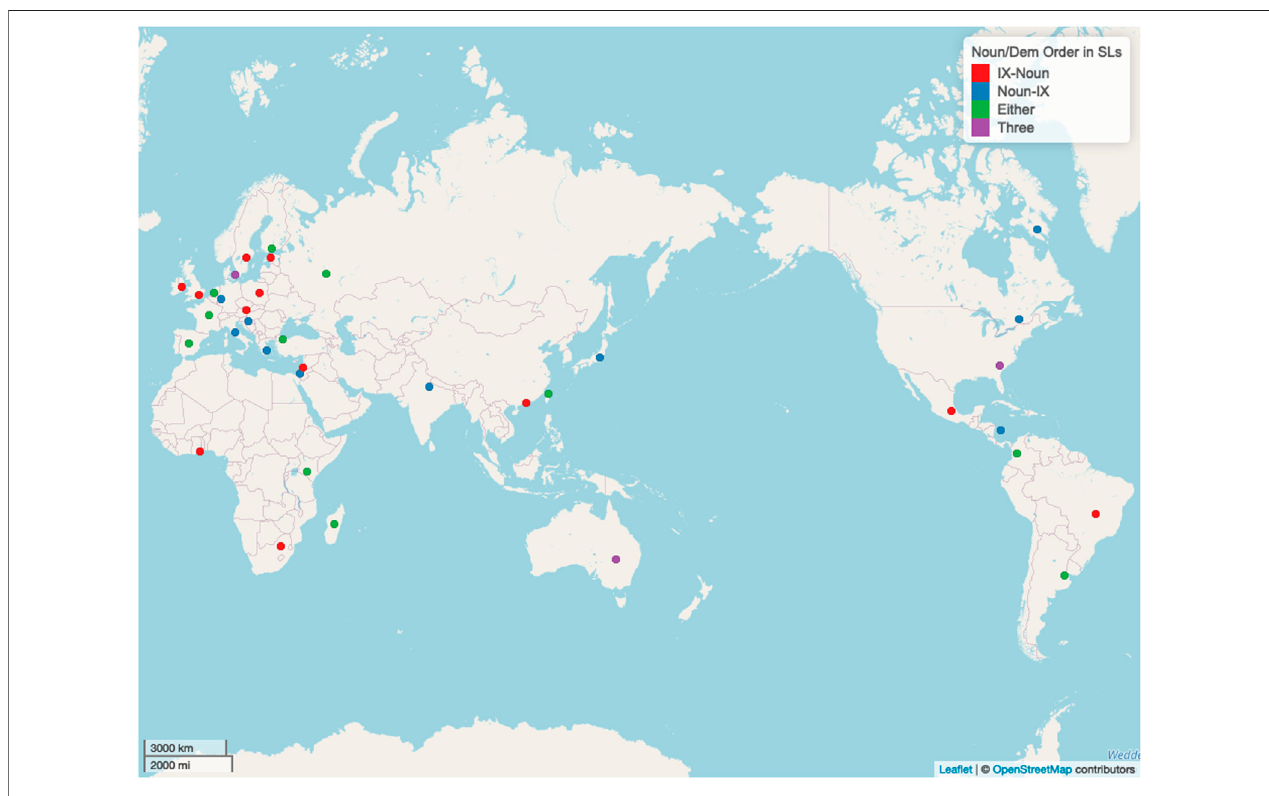
FIGURE 4 | Map of noun/demonstrative order in sign languages.